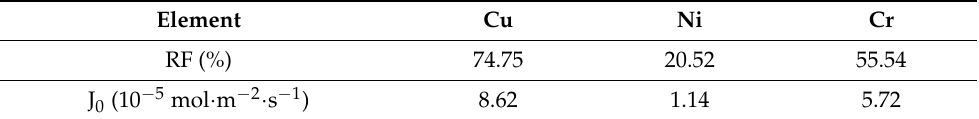
Table 3. Recovery factor and initial fluxes (J 0 ) for copper (II), nickel (II) and Chromium (III) transport through PIM